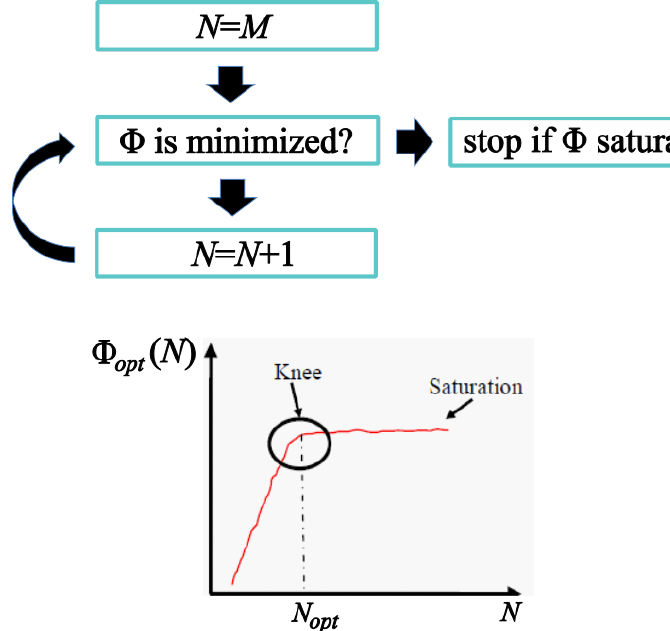
Figure 2. Flow chart for the determination of the number N of sampling